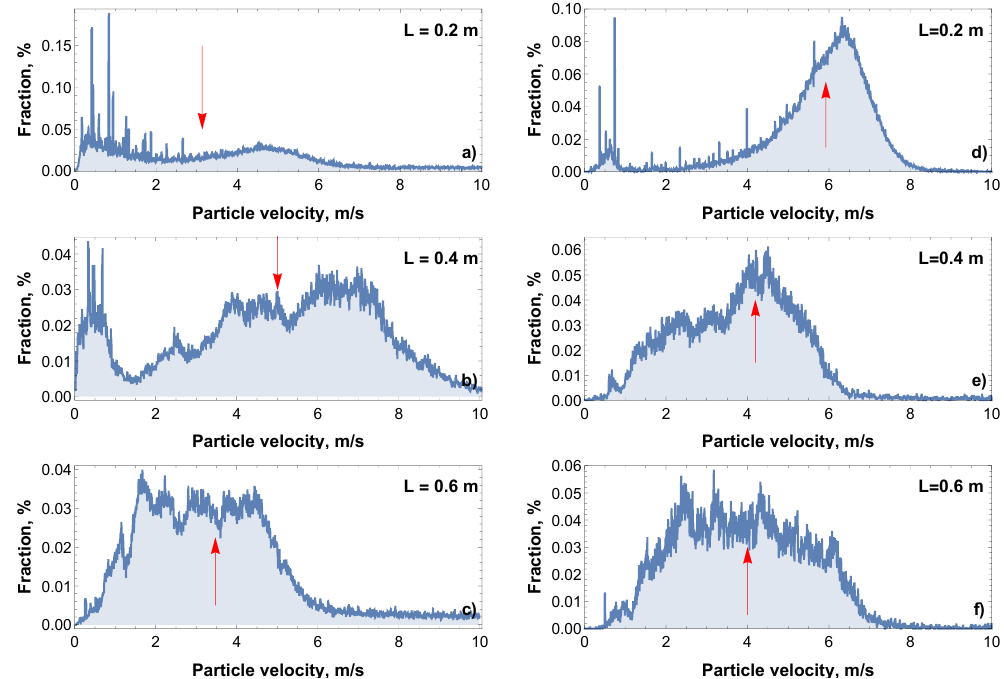
Figure 3. The measured velocity distributions of the aerosol particles at different distances from the nozzle for CWS ( a – c ) and CWSP ( d – f ). The first moment of the distribution corresponds to the size shown by red